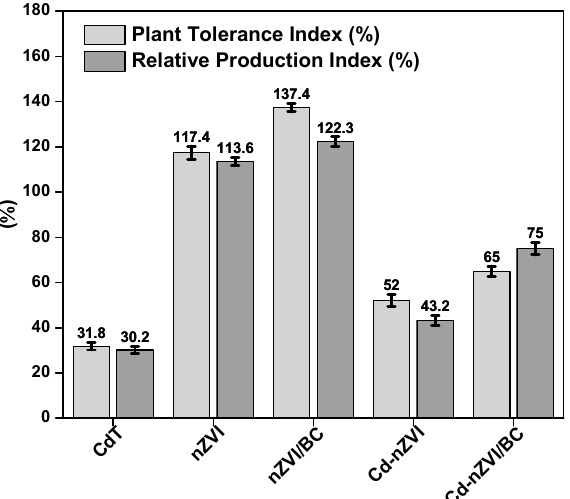
Figure 9. Impact of nZVI and nZVI/BC application on plant tolerance index and relative production index factors in normal and Cd ‐ polluted soils. Bars not sharing the same lower ‐ case letter are significantly different (Tukey’s HSD α < 0.05). Represented data are the means of three replications ( n = 6) with ± standard deviation.